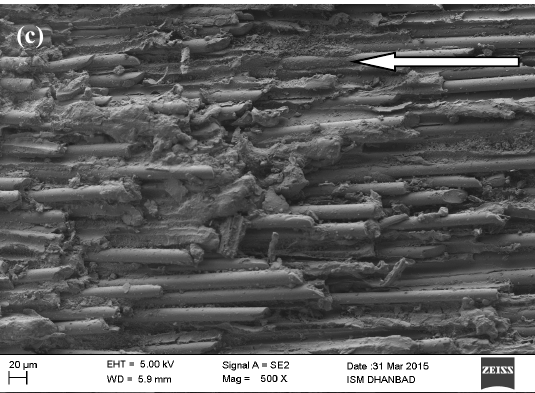
Figure 9. CNT filled GFRP composite worn out surface for argon environment sliding at 3.14 m/s and for ( a ) 40 N, ( b ) 80 N and ( c ) 120 N.